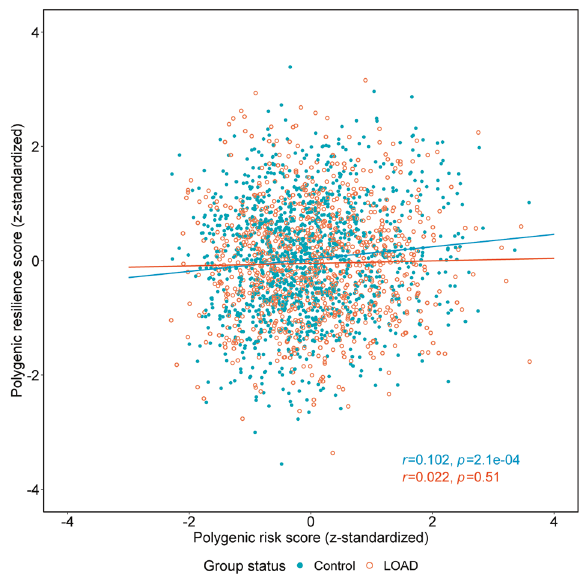
Fig. 3 The correlation of standardized polygenic risk scores (PRSs) and polygenic resilience scores (design 1) in normal controls and late-onset Alzheimer ’ s disease (LOAD) cases. The analyses were performed in three independent replication studies not used in the resilience score derivation steps (i.e., ADC7, AddNeuroMed, and ADNI-GO/2/3; normal controls, n = 1321; LOAD cases, n = 943). The optimal P -value threshold for polygenic risk- scoring was 0.5, and the optimal P -value threshold for polygenic resilience scoring was 0.1 (see Fig. 2). The blue round dots indicate normal controls, and the orange circles indicate LOAD cases. The blue and orange lines represent the best fi t for correlations between PRSs and resilience scores in normal controls and in LOAD cases, respectively. The blue and orange annotation text shows the Pearson correlation coef fi cient (r) and the P -value between PRSs and resilience scores in normal controls and LOAD cases, respectively. In this analysis, we excluded ultra-high-risk LOAD cases whose PRSs are higher than the maximum of all normal controls, and ultra-low-risk normal controls whose PRSs are lower than the minimum of all LOAD the standardized polygenic resilience scores of the optimal P < 0.1 threshold in design 1 exhibited a signi fi cant positive correlation with PRSs in normal controls (Pearson ’ s r = 0.102, 95% CI = 0.048 – 0.155, degree of freedom [df] = 1319, P = 2.1e-04), (Pearson ’ s r = 0.022, 95% CI = − 0.042 – 0.085, df = 941, P = 0.51) (Fig. 3). As expected, the correlation coef fi cient between polygenic risk scores and polygenic resilience scores in normal controls was signi fi cantly larger than the one in LOAD cases ( P = 0.03, one- tailed test).